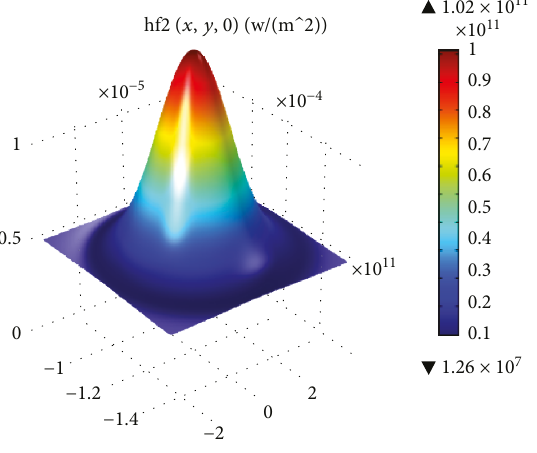
Figure 4: Gaussian laser energy density.